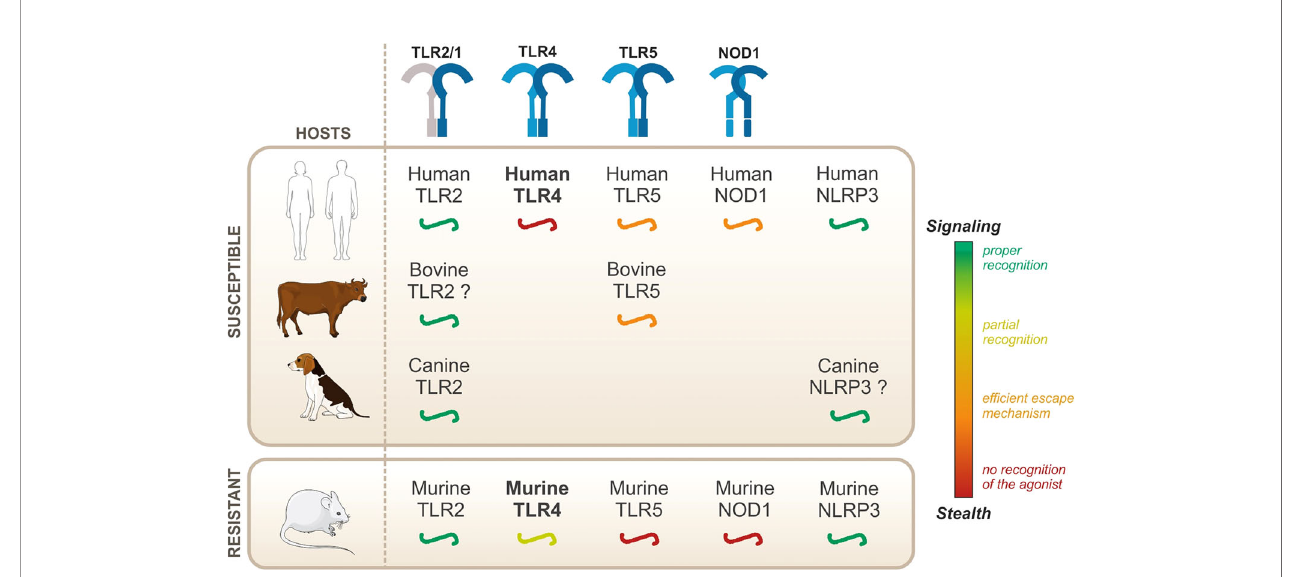
FIGURE 7 | Overview of the species-speci fi city of PRR recognition of